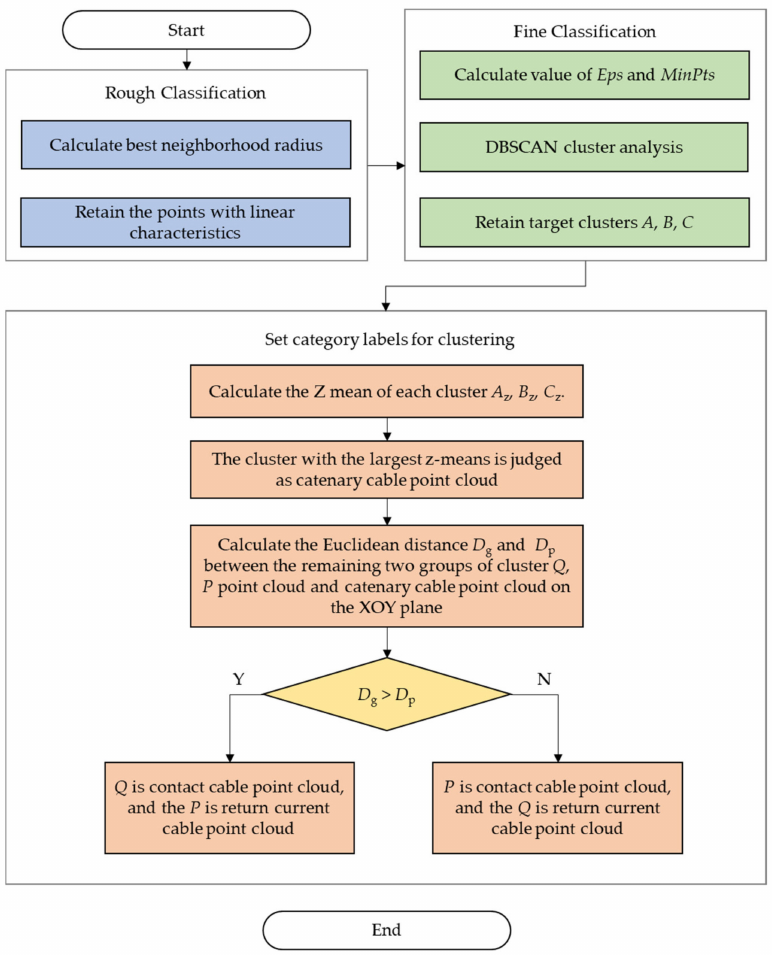
Figure 3. Flow chart of DBSCAN classification algorithm considering OCS